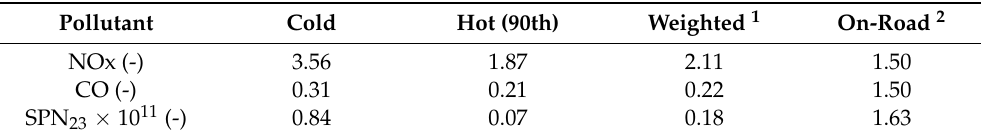
Table 3. Conformity factors of the real-world cycle (RWC) according to the Euro VI step E methodol- ogy for in-service conformity (ISC)-like testing.